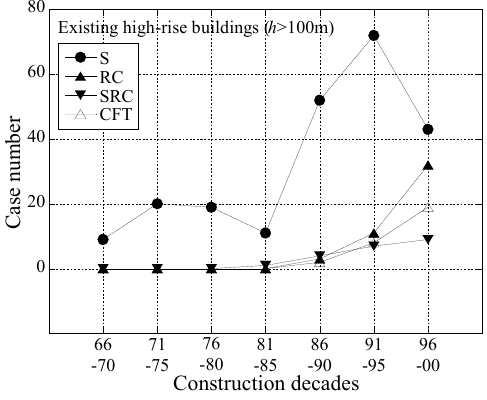
Figure 4. Statistical databases of various existent high ‐ rise buildings.